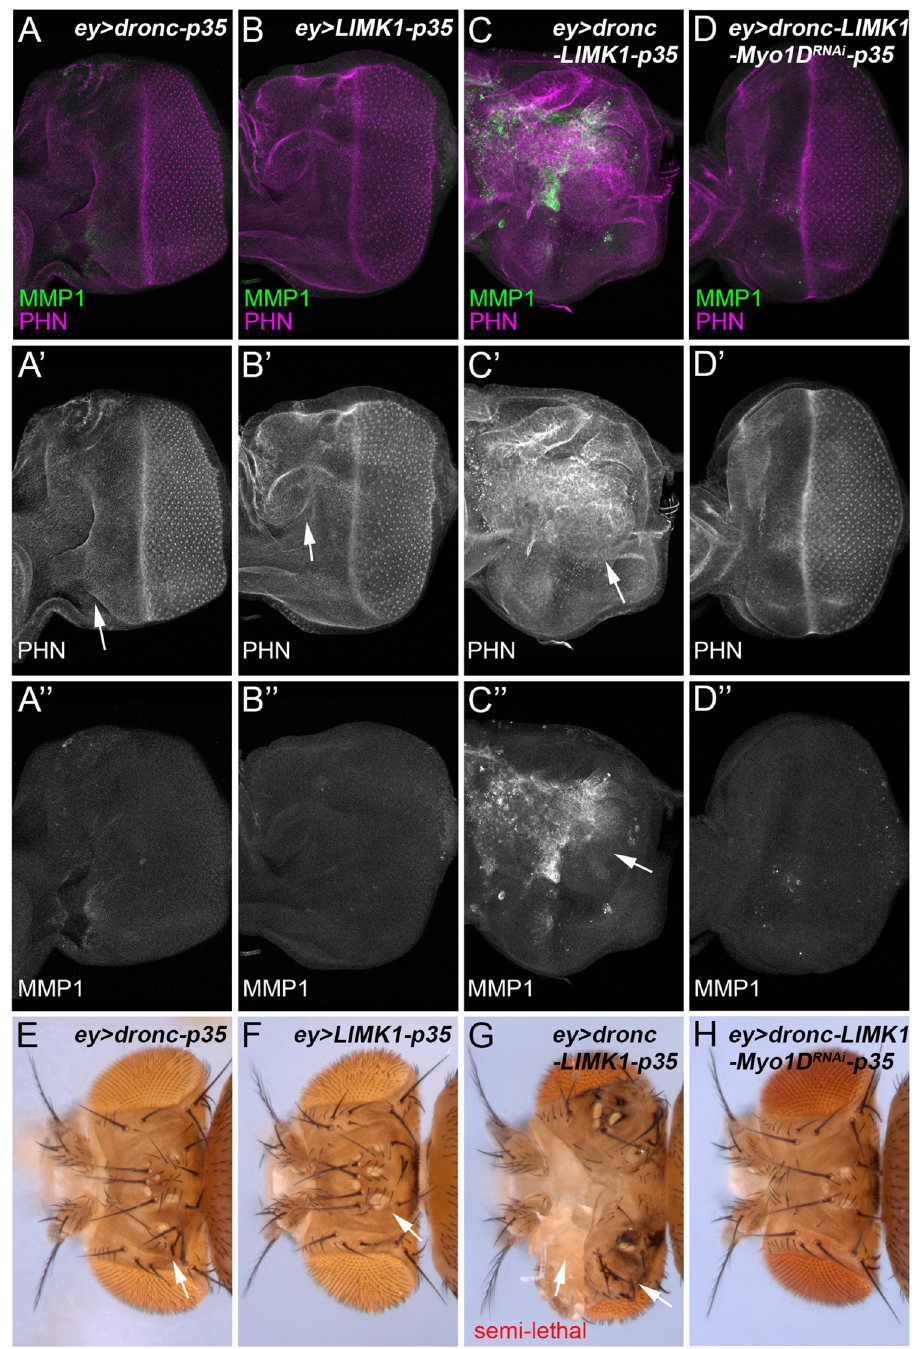
Fig 7. Dronc and LIMK1 drive F-actin polymerization and tissue overgrowth via Myo1D. (A-D”) Late 3 rd instar eye discs labelled with PHN (magenta in A-D and grey in A’-D’) and MMP1 (green in A-D and grey in A’’-D’’). Expression of dronc (A, A’) or LIMK1 in ey > p35 discs results in a moderate F-actin accumulation as indicated by the PHN labelling and a slight tissue overgrowth (A-B’, arrows). No obvious MMP1 signals are induced in these genetic backgrounds (A”, B”). In contrast, co-expression of dronc and LIMK1 induces a strong accumulation of F-actin and a massive overgrowth of ey > p35 discs (C, C’, arrow). These are associated with a strong increase of MMP1 signals (C”, arrow). Such tissue overgrowth, increase of F-actin accumulation and MMP1 signals are suppressed by an RNAi knockdown of Myo1D (D-D”), an unconventional myosin. (E-H) Representative adult fly head images of the indicated genotypes. Expression of dronc (E) or LIMK1 (F) in ey > p35 causes weak to moderate head capsule